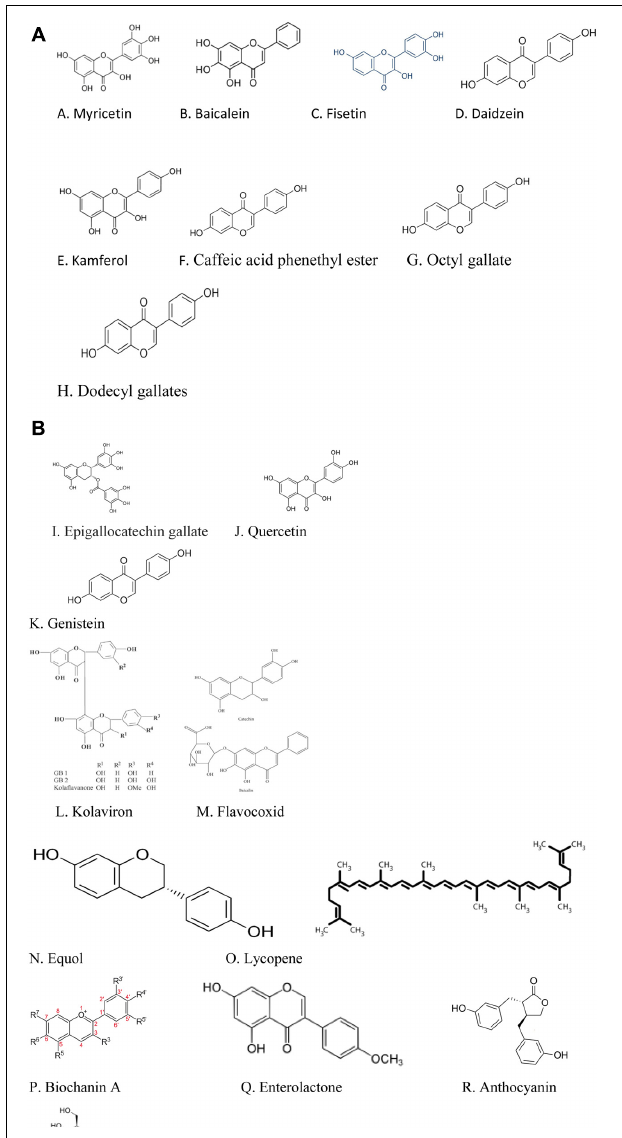
FIGURE 1 | (A) Structures of the polyphenols with 5 α -reductase inhibitory actions. (B) Structures of polyphenols with BPH suppressing actions in preclinical